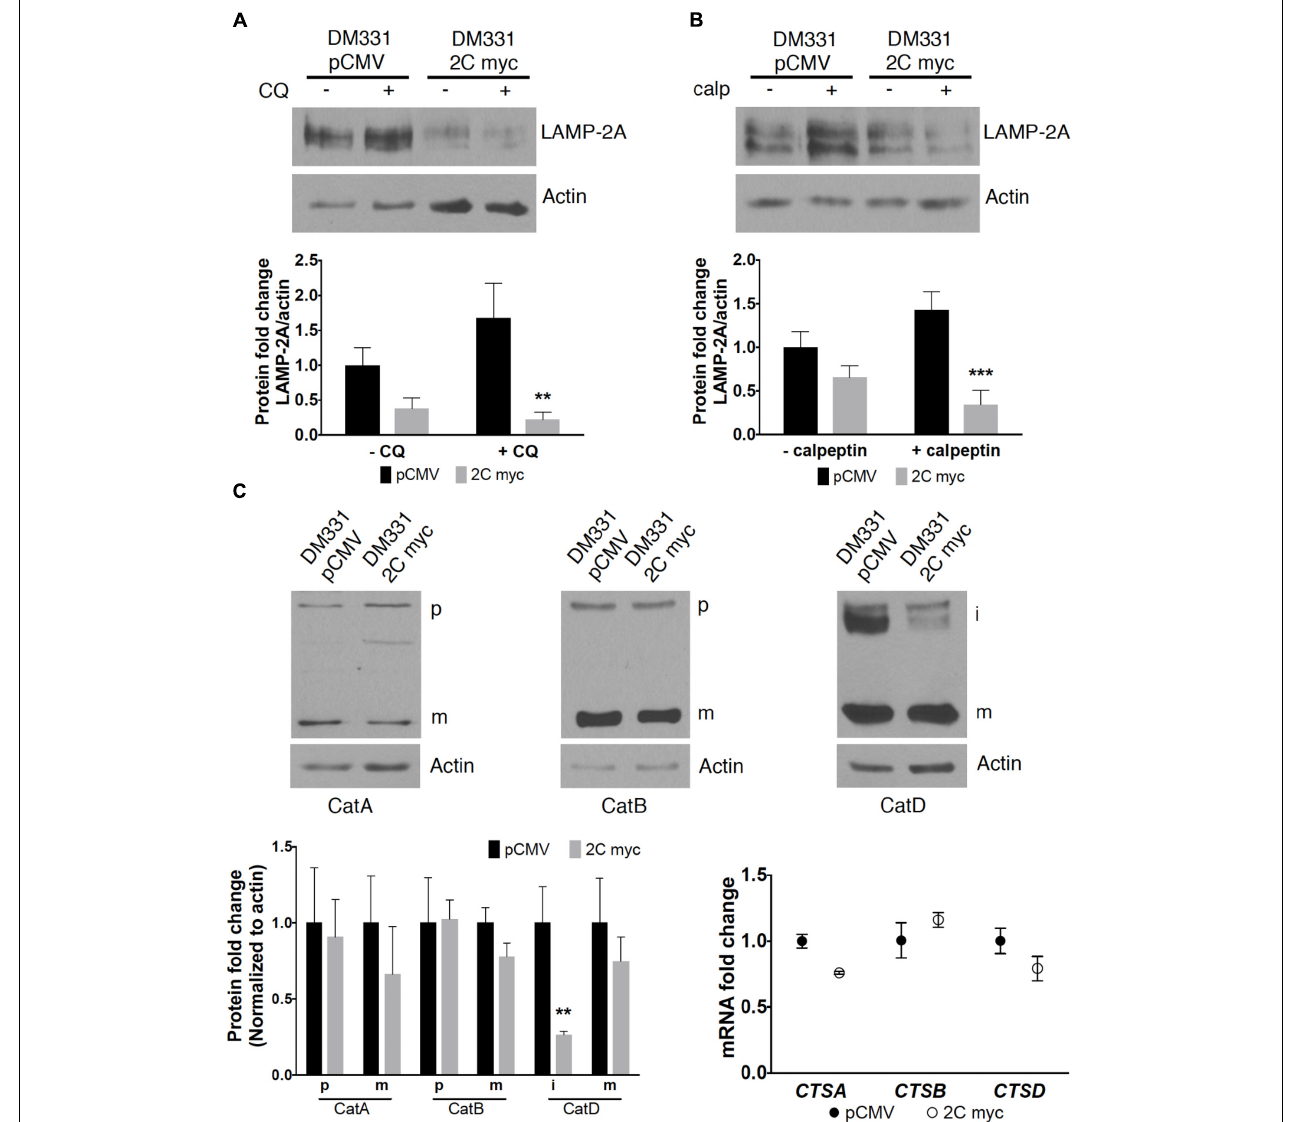
FIGURE 4 | Changes in LAMP-2A protein expression were not due to increased cathepsin or calpain abundance in melanomas expressing LAMP-2C. DM331 pCMV and DM331 2C myc cells were incubated overnight at 37 ◦ C with ± 20 µ M CQ (A) or 10 µ M calpeptin (calp) (B) to inhibit lysosome proteases or calpain activity, respectively. LAMP-2A levels were detected by western blotting, evaluated by densitometry, and normalized to actin protein levels. LAMP-2A levels were calculated relative to DM331 pCMV cells cultured without CQ or calpeptin. (C) Maturation and gene expression of lysosome proteases cathepsin A (CTSA), cathepsin B (CTSB), and cathepsin D (CTSD) was evaluated in cells overexpressing LAMP-2C. Lysates were resolved by SDS-PAGE and probed to detect the precursor (p), intermediate (i), or mature (m) form of cathepsin A, cathepsin B, and cathepsin D. Protein expression was quantified by densitometry and levels were normalized to actin levels. mRNA levels of CTSA , CTSB , and CTSD transcripts were analyzed by qPCR and normalized to 18S expression. Measurements in (A–C) are relative values calculated by setting the results obtained for DM331 pCMV cells equal to one for comparison to DM331 2C myc cells. Data were analyzed by two-way ANOVA. ∗∗ p < 0.01, and ∗∗∗ p < 0.001 ( n =